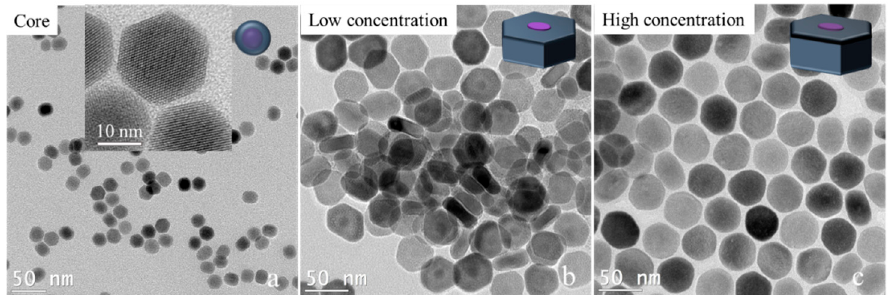
Figure 4. TEM images of NaGdF 4 /NaYF 4 core nanocrystals before ( a ) and after shell growth with a low shell precursor concentration ( b ) and a high shell precursor concentration ( c ). Insert in ( a ) is the high-resolution TEM image for the corresponding sample.